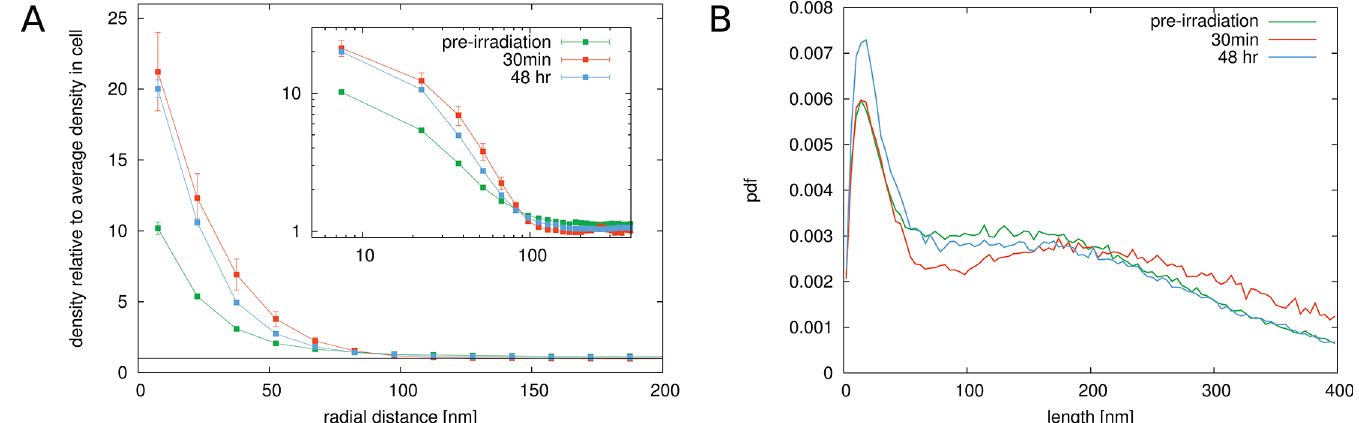
Fig 9. Results for cells exposed to 0.5 Gy radiation. Panel A. The figure shows the radial radial distribution function for H3K4 antibodies representing euchromatin (methylated histone variants) for non-irradiated and irradiated cells. Error bars represent the standard deviation of the mean value after averaging over the sample of cells. The value for g ( r ) at small distances goes up to around 20, indicating the high marker densities during repair. The rapid drop off of the radial distribution function within a distance of about 50 nm shows that euchromatin forms small clustered areas. Upon exposure to 0.5 Gy γ - irradiation, a change in the correlation function can be observed in cells that were imaged after 30 min and 48 hrs. The value at small radial distances increases compared to non-irradiated cells. This indicates that the density in the euchromatic regions becomes on average higher in irradiated cells. Panel B. The distribution of edge lengths in the Delaunay triangulation of the markers confirms these observations. A sharp peak in the distribution at around 30 nm can be seen in untreated cells. In 48 h post-irradiation cells, the peak spreads